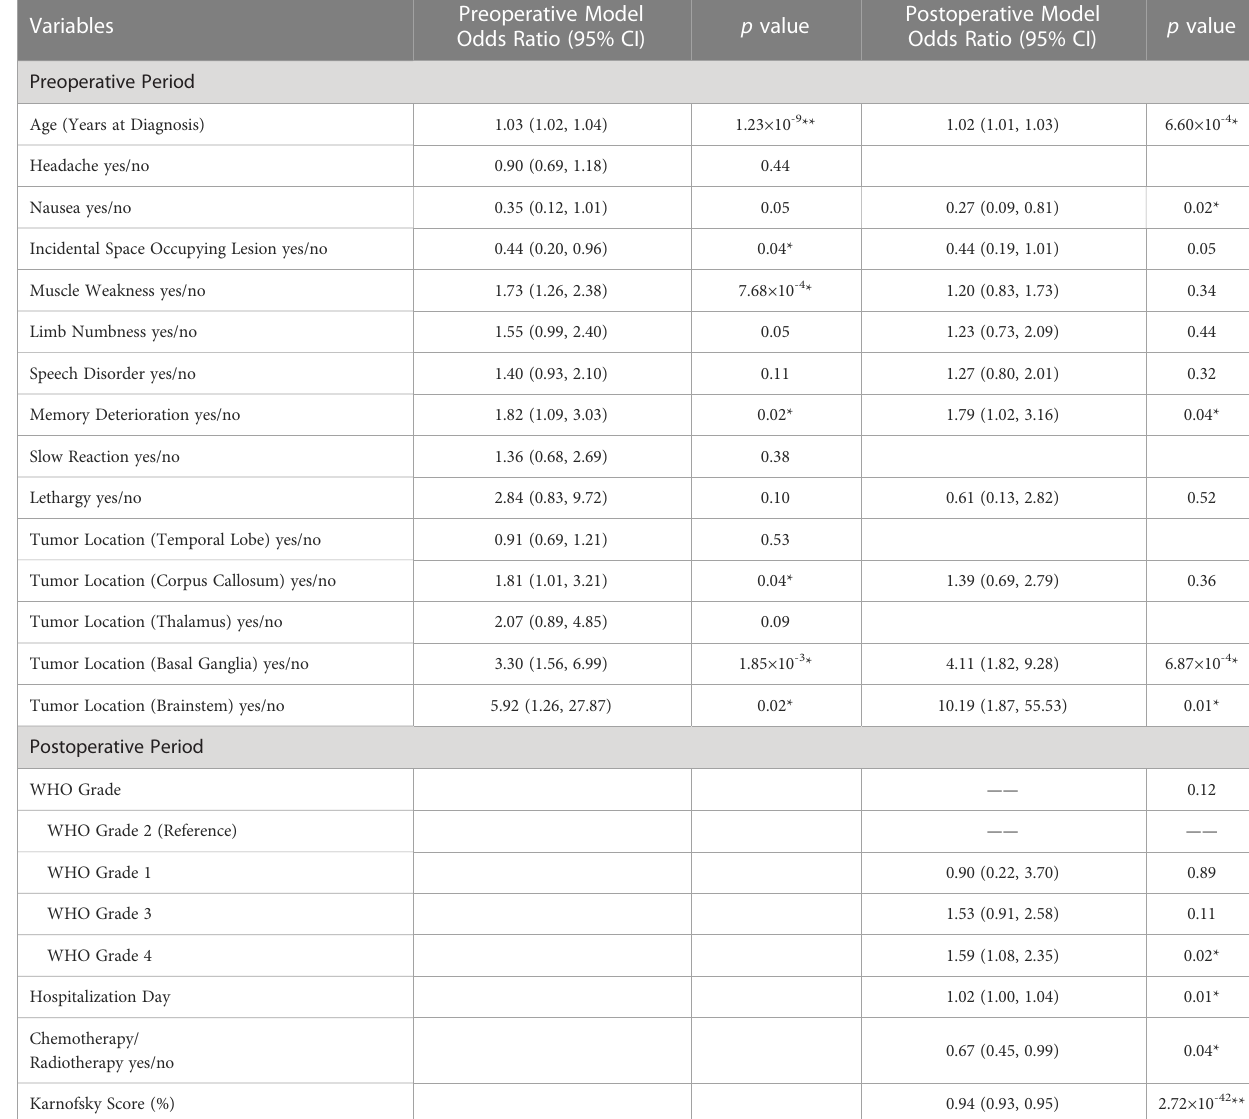
TABLE 2 Multivariable logistic regression model for predicting postoperative mental health disorders in glioma